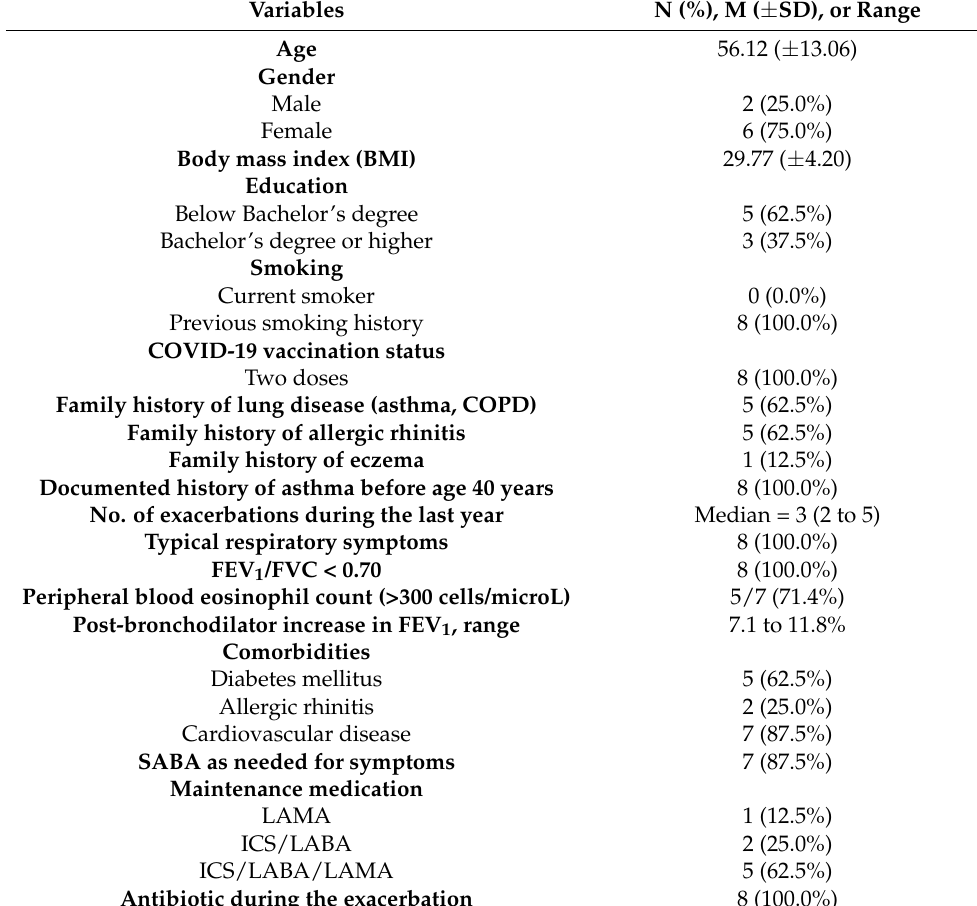
Table 1. Demographics and clinical data for the study participants (N =